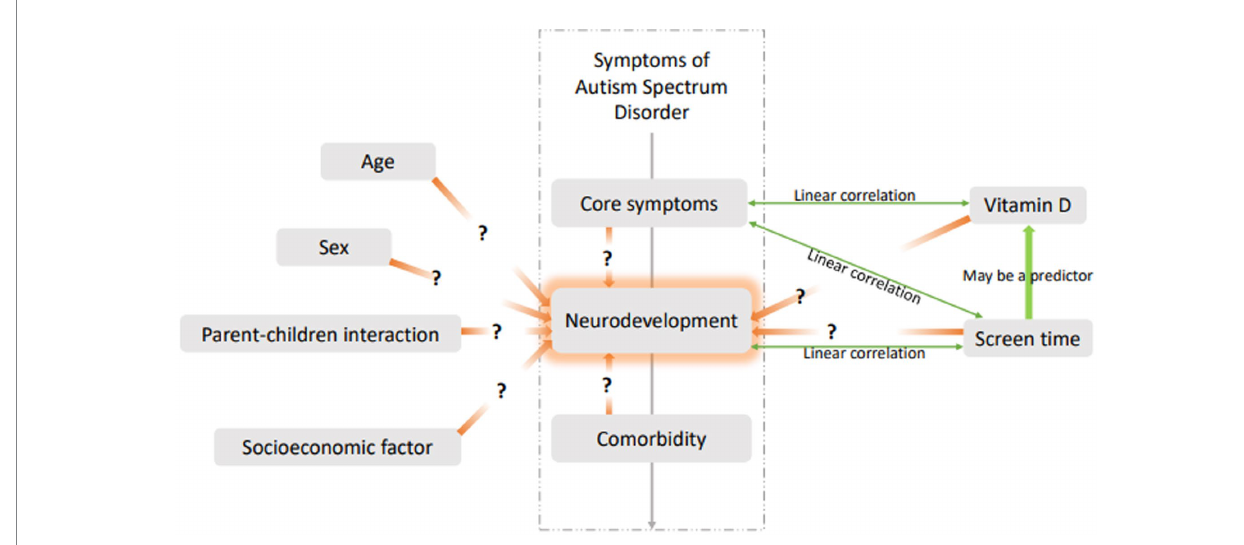
FIGURE 1 Hypothesis of predictive model for influencing factors of neurodevelopment in children with ASD.